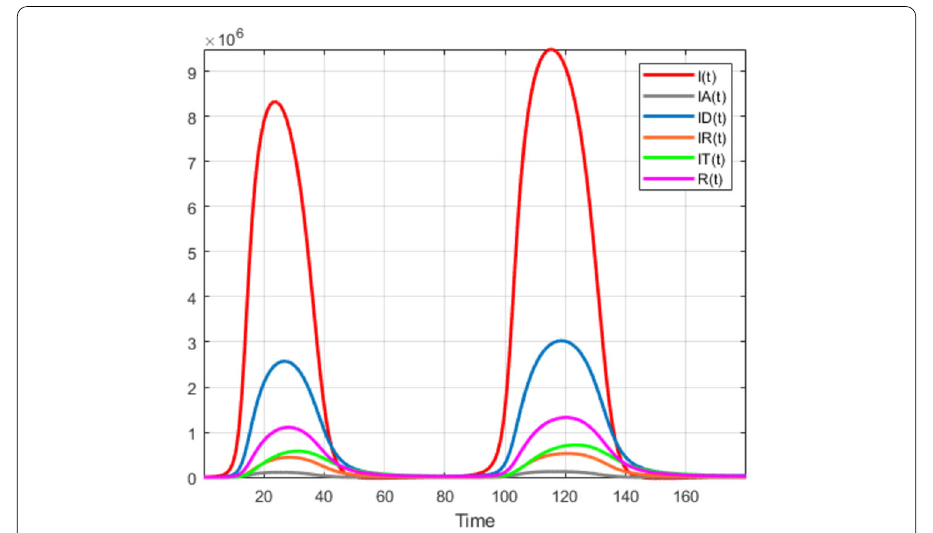
Figure 26 Numerical visualization of COVID-19 model for α =